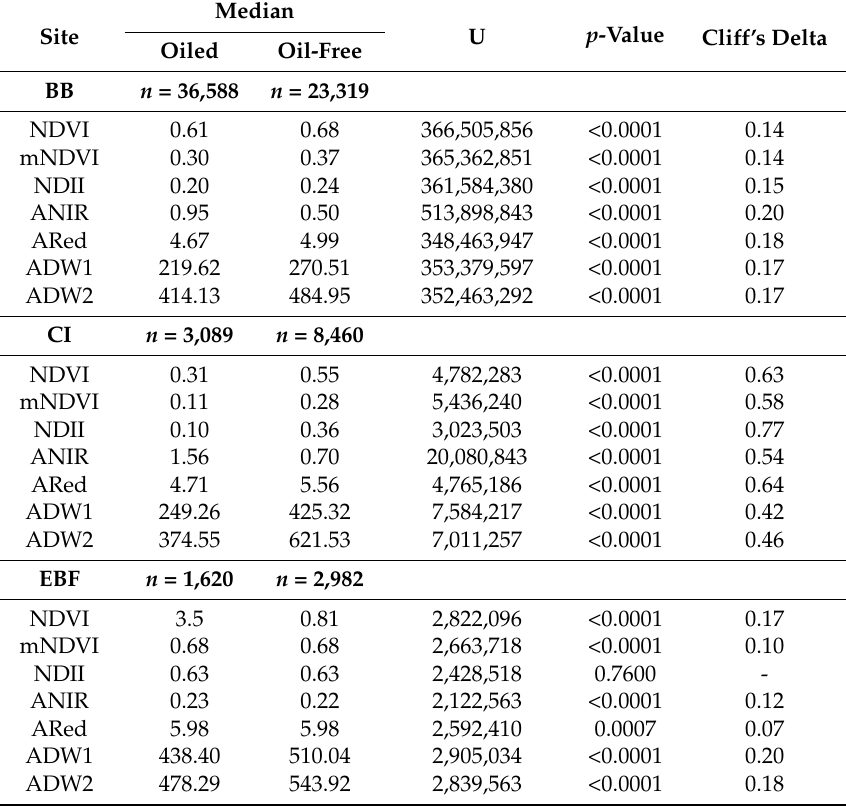
Table 3. Median values for each index for oil and oil-free shorelines, the U statistic and p -values from the Mann-Whitney Test and the effect size as calculated with Cliff’s delta. n indicates total number of pixels in each study site for all oiled shorelines and oil-free